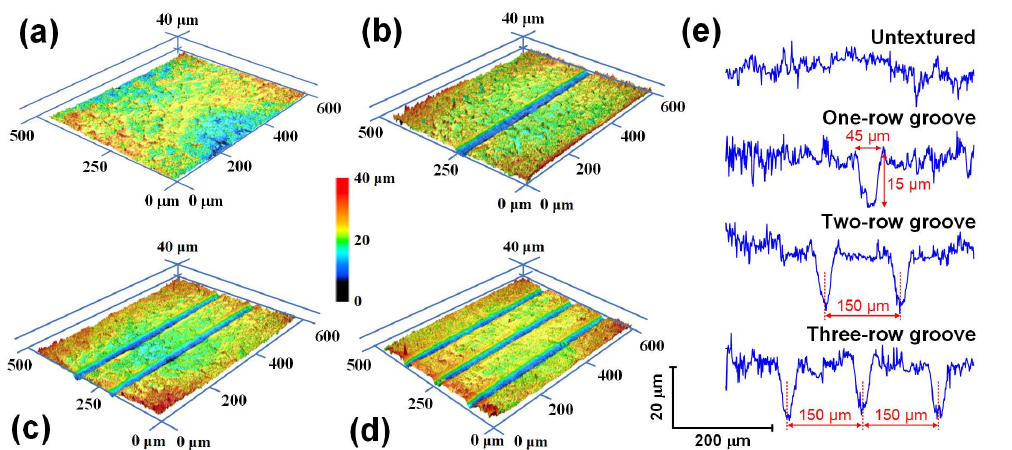
Figure 5. Surface morphologies of bracket slots with different textures. Three-dimensional optical images of bracket with ( a ) no texture, ( b ) one-row groove, ( c ) two-row groove, and ( d ) three-row groove. ( e ) Two-dimensional cross-sectional profiles of untextured and micro-groove textured stainless steel brackets.